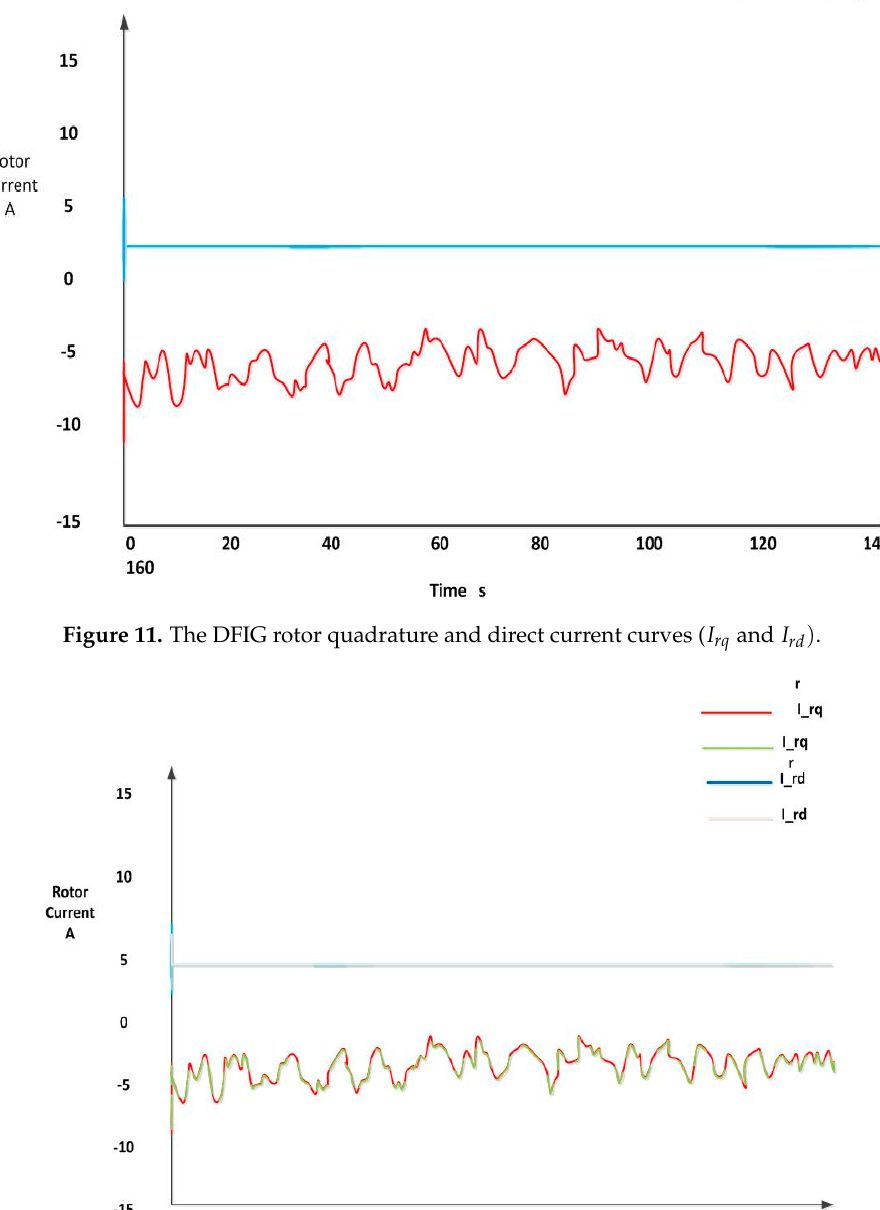
Figure 12. Non-linear control tracking rotor quadrature and direct currents and their references.